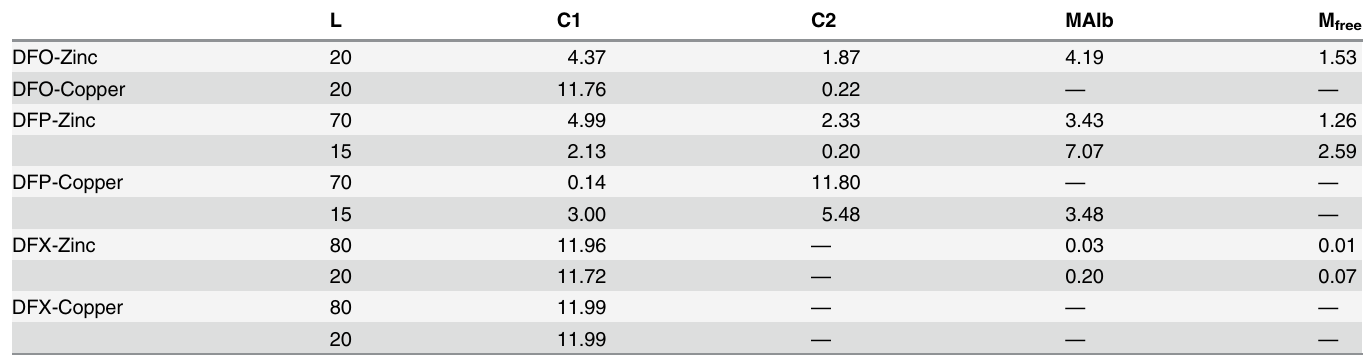
Table 3. Speciation study of the systems “ Albumin ” -iron chelator-metal iron. Concentration of the complexes formed between metal ions and iron che- lators in presence of albumin, expressed as μ mol/L. C1 and C2 represent the complexes MLH 2 and MLH with DFO, and ML and ML 2 with DFP and DFX. L